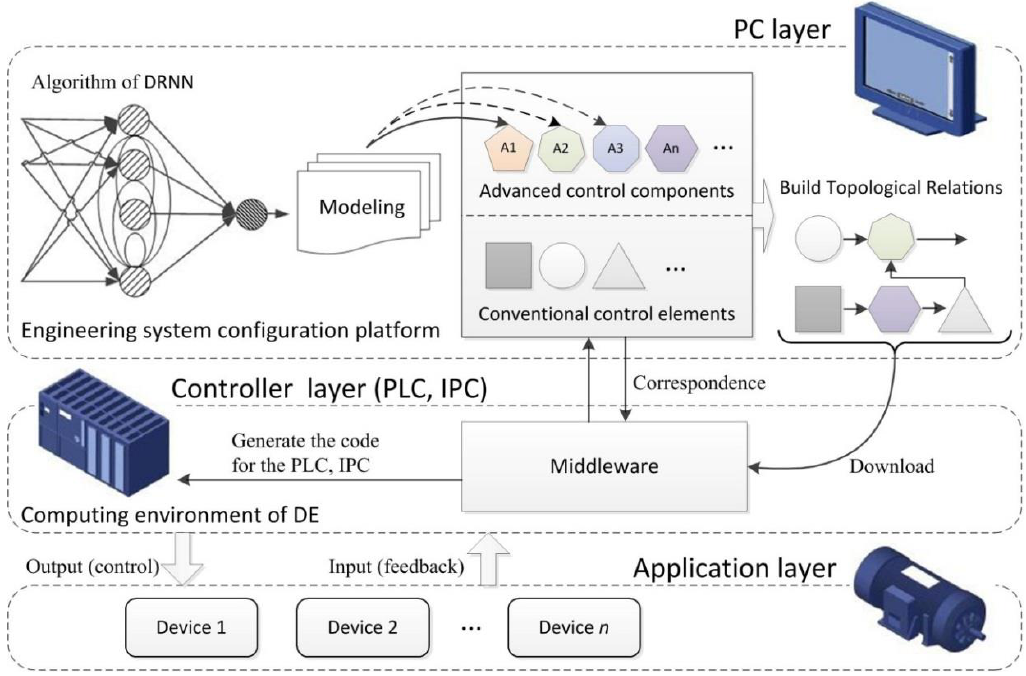
Figure 7. The abstract platform architecture of the DRNN hybrid controller.